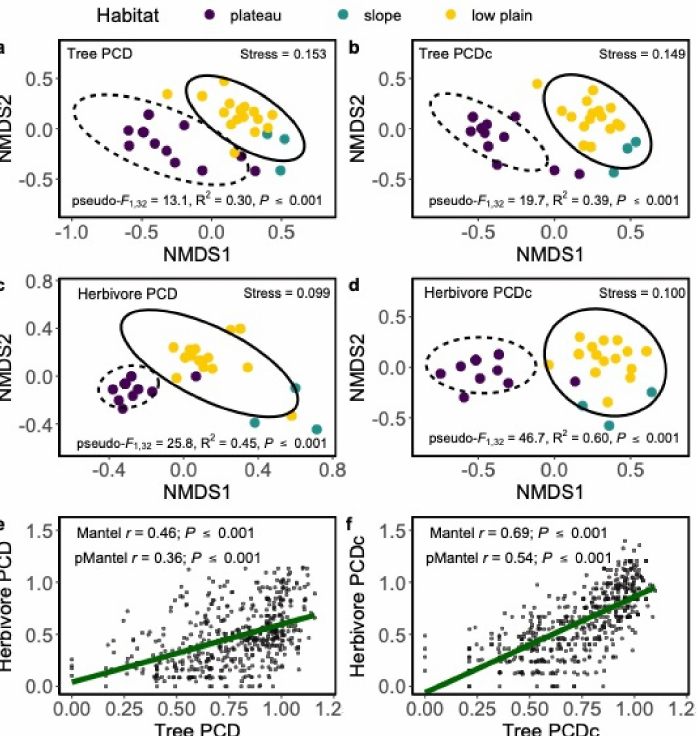
Figure 4. Taxonomic and phylogenetic differentiation in woody-plant and large-herbivore communi- ties. Nonmetric multidimensional scaling (NMDS) revealed significant compositional dissimilarity in ( a ) tree PCD, ( b ) tree PDCc, ( c ) large-herbivore PCD, and ( d ) large-herbivore PCDc between habitats. Colors in ( a – d ) indicate habitat at each grid site. Results of perMANOVAs and stress values for corresponding NMDS plots are shown on each panel. We grouped the three slope sites with low plain sites for calculating perMANOVAs and 95% confidence ellipses. The ( e ) PCD and ( f ) PCDc of plant and animal communities were positively correlated based on Mantel and (p)artial Mantel tests; green trendlines were fit using generalized linear